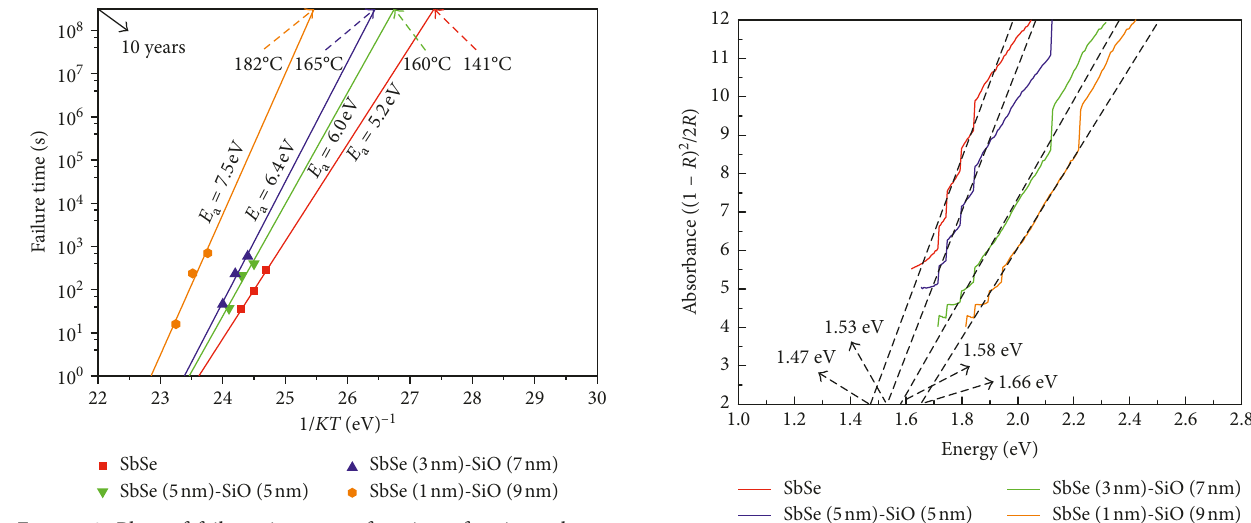
Figure 2: Plots of failure times as a function of reciprocal tem- perature of SbSe and SbSe/SiO multilayer thin